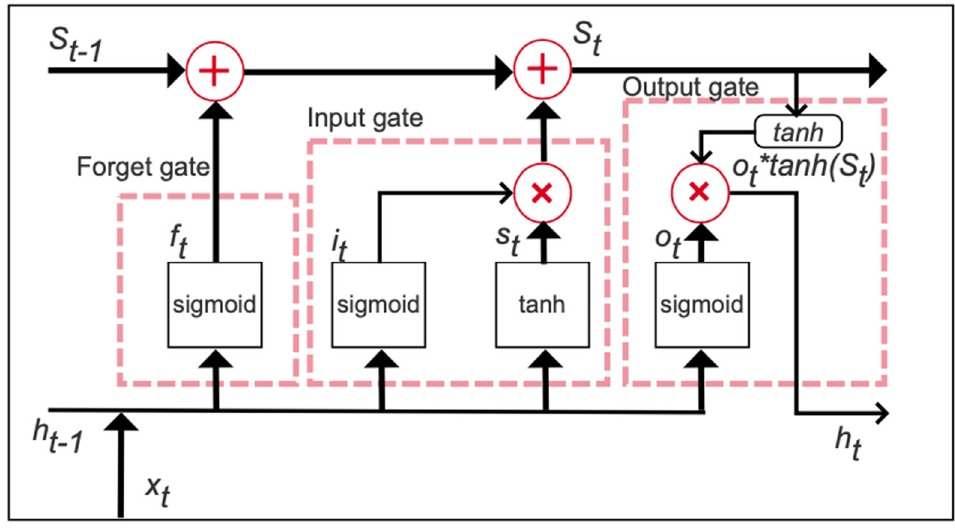
Figure 6. Network structure of LSTM.